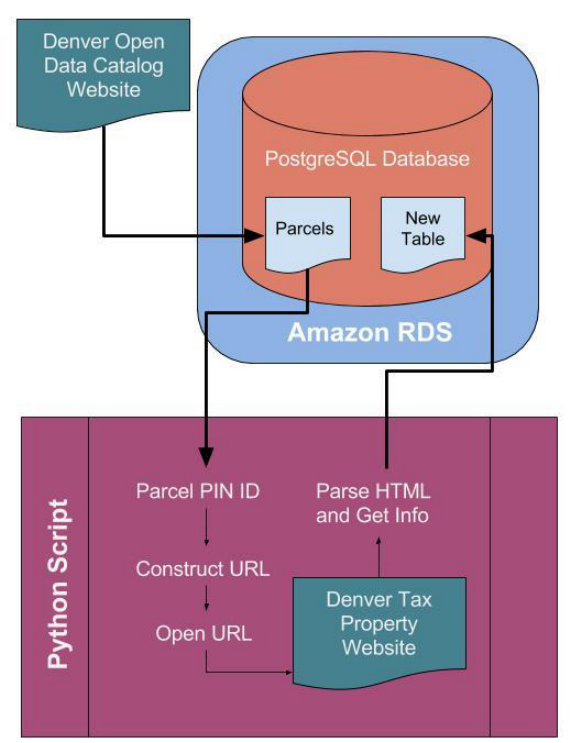
Figure 1. An overview of our